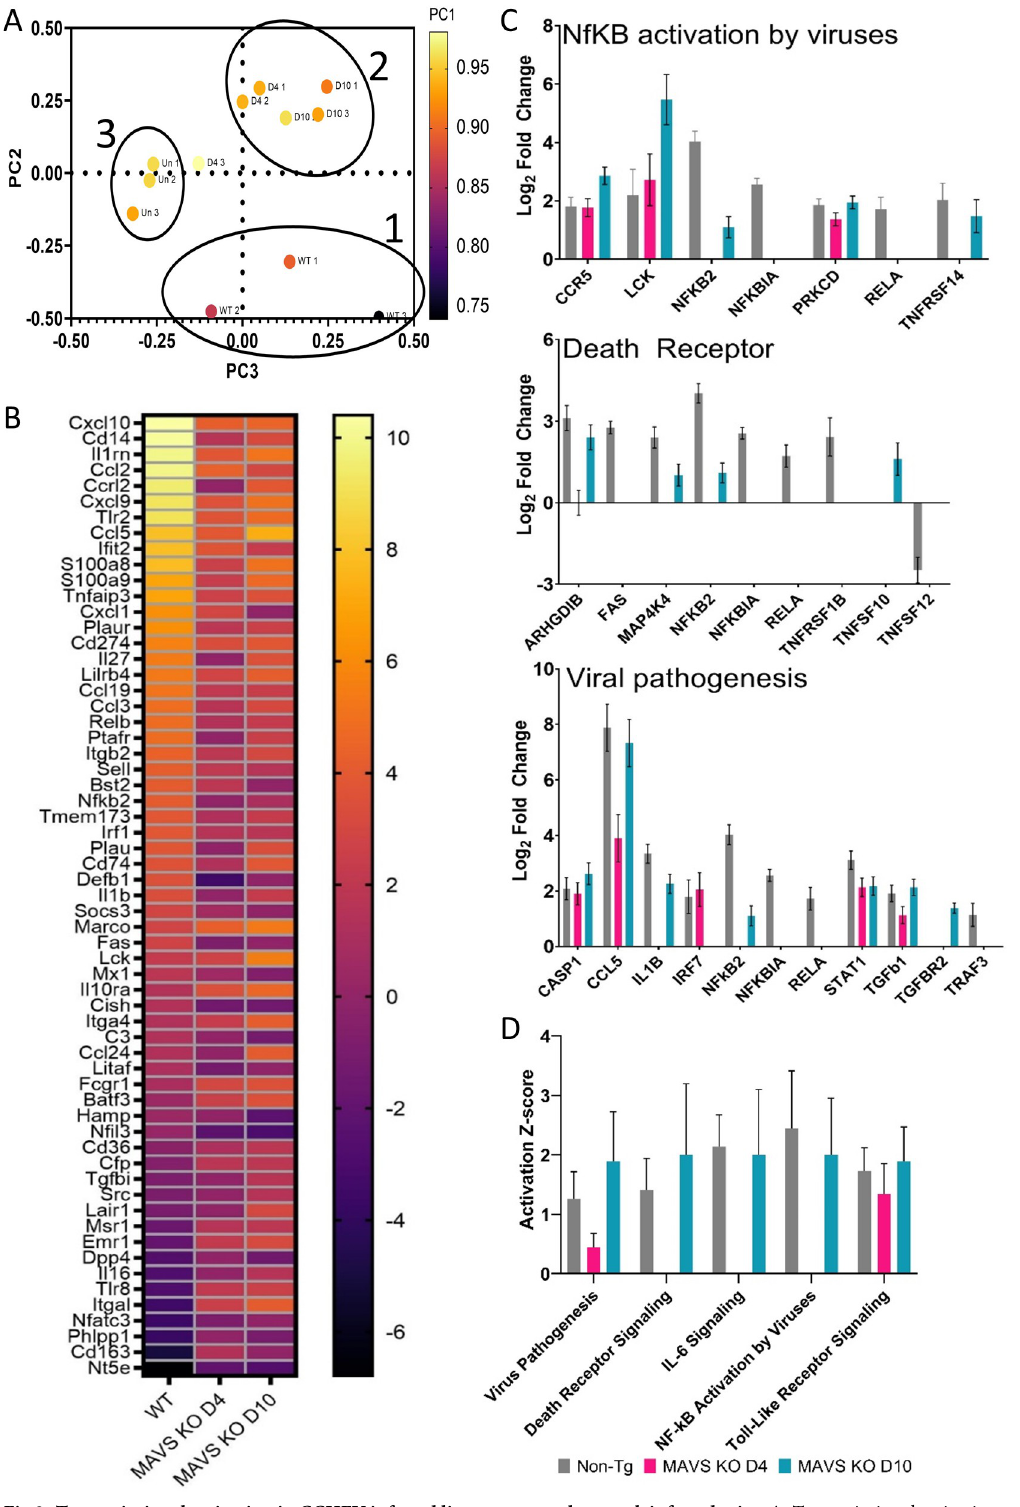
Fig 3. Transcriptional activation in CCHFV infected livers compared to mock infected mice. A. Transcriptional activation in liver homogenates from mice (n = 3 per group/time point) infected with CCHFV with IFN-I blockade or mock infected were examined by NanoString. Principal Component Analysis (PCA) was performed by nSolver analysis software. Circles